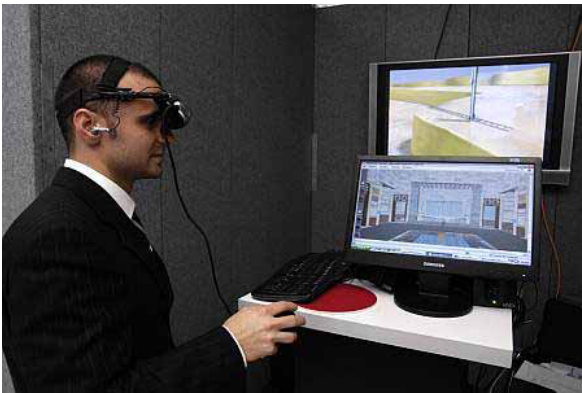
Figure 4. Proposal for a three-dimensional interactive and navigable, accessible technology through active 3D stereo HMD. without a mouse and joystick. Just wearing a helmet and moving the head you can pass through the rooms and visit the house, which was rebuilt in its entirety.